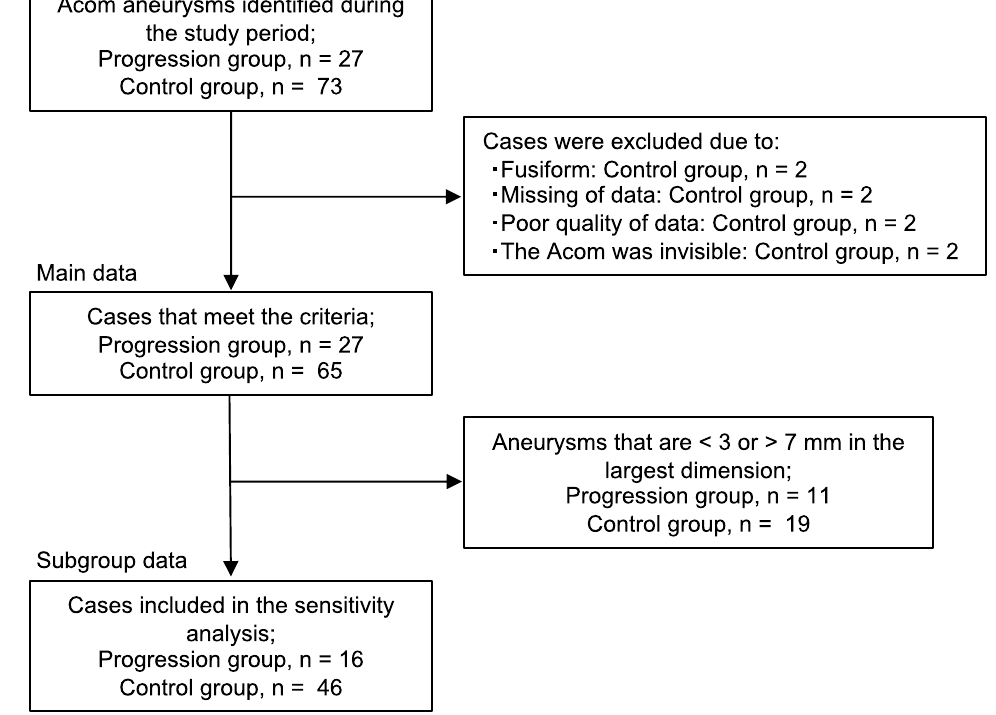
Figure 4. Patient enrollment flowchart in the case–control study. Acom anterior communicating